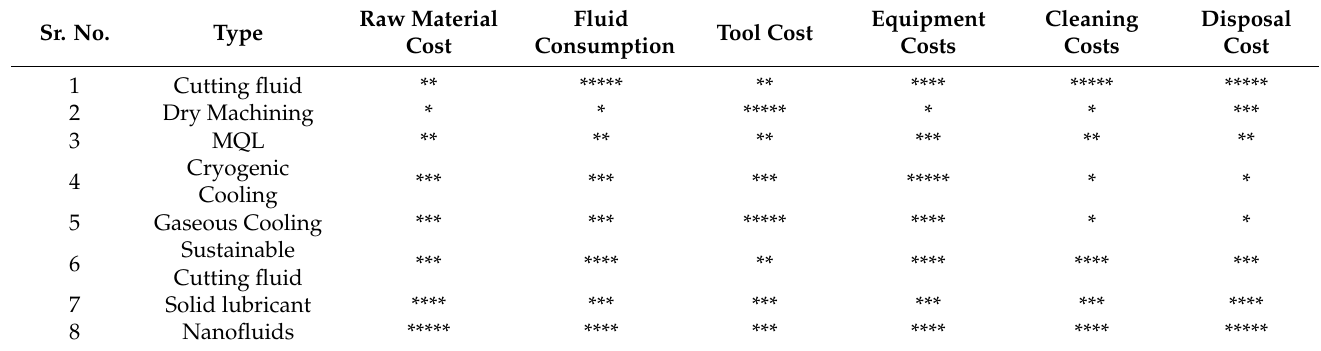
Table 10. Qualitative Cost Estimation data for different cooling/lubricating techniques, reprinted with permission from ref. [109]. Copyright 2017 Elsevier Ltd. The symbols used to depict Very low (*), Low (**), Medium (***), High (****), Very High (*****). Sr.